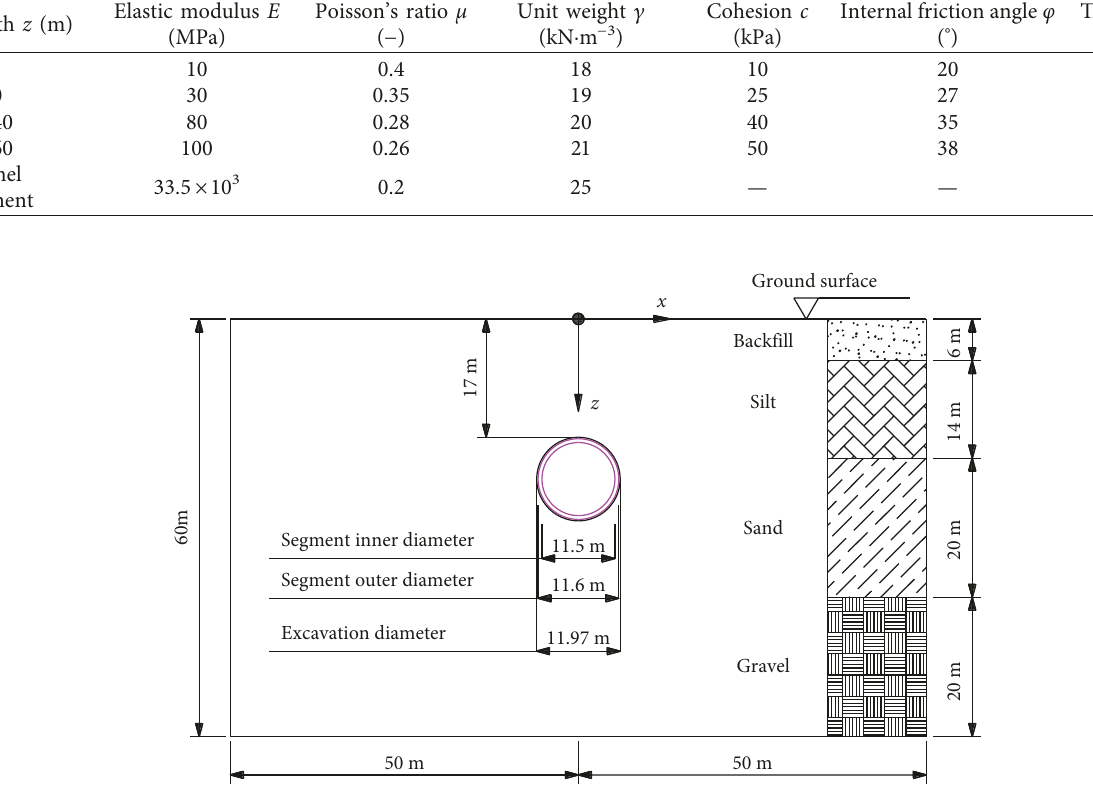
Figure 8: Typical cross section of the